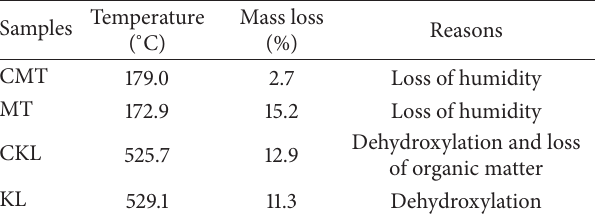
Table 1: TG results of samples (MT, CMT, KL, and CKL). Temperature Samples ( ∘